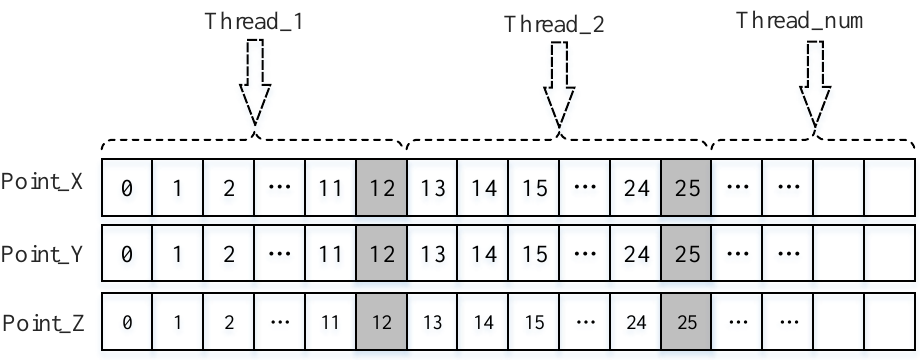
Figure 6. Data organization structure.